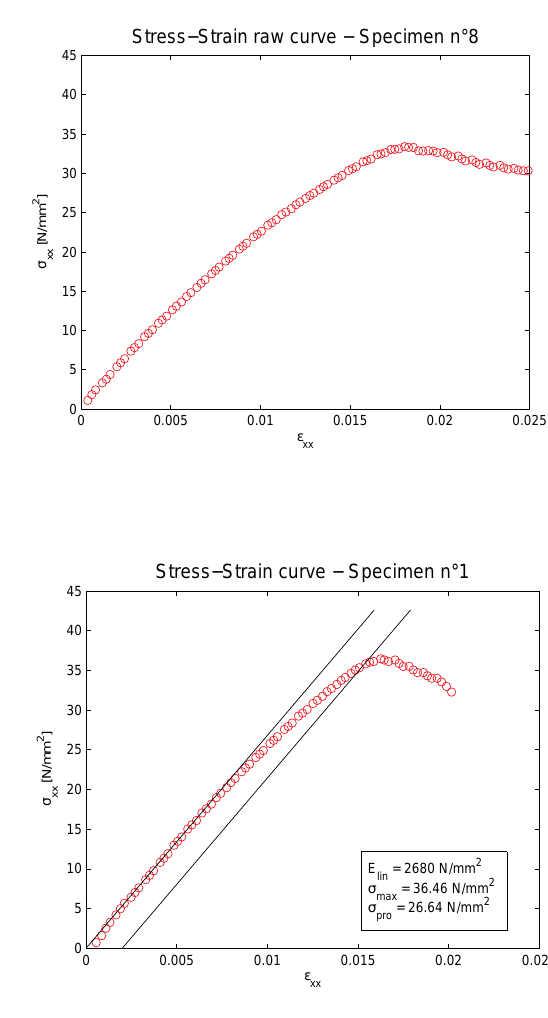
Figure 10: Crossed-sectional section of the broken specimen after the test. Figure 11: Actual stress-strain curve for specimen